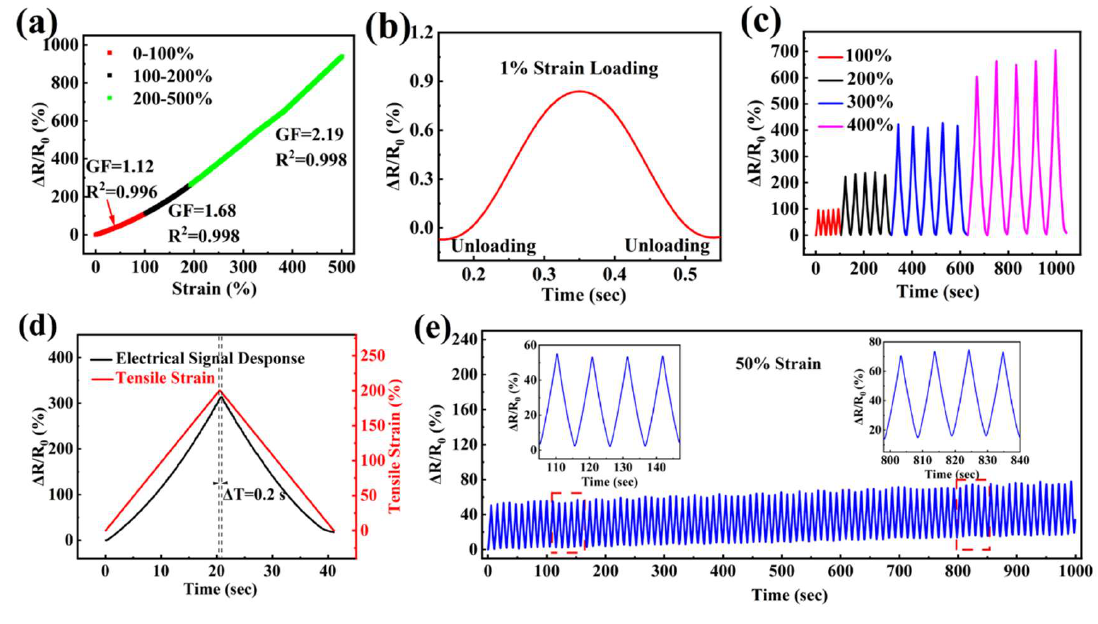
Figure 6. ( a ) GF of the LiCl/p(HEAA−co−BD) hydrogel flexible sensor. The change of relative resistance of the hydrogel flexible sensor during the loading–unloading cycle with a strain of ( b ) 1%, ( c ) 100–400%. ( d ) time−resolved responses of hydrogel flexible sensor. ( e ) The stability of the hydrogel flexible sensor.